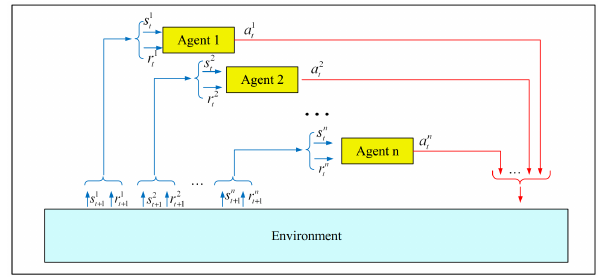
Figure 9. Multi-agent learning